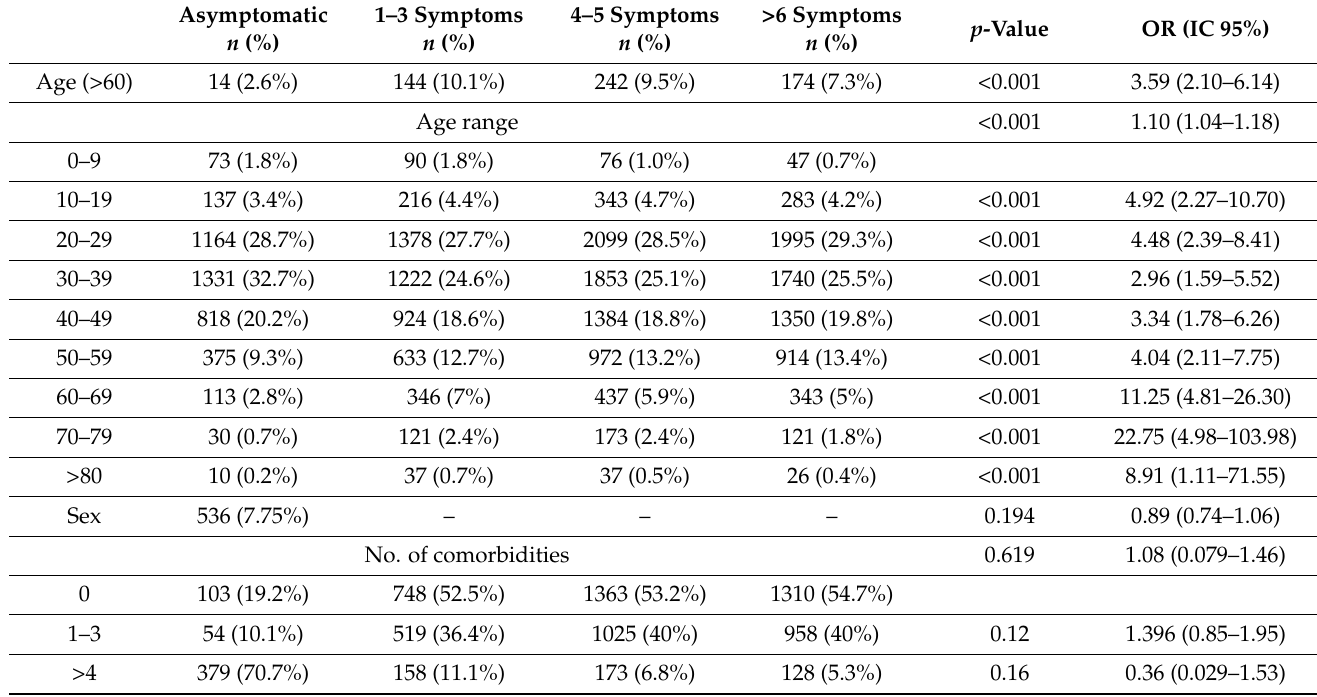
Table 3. Risk factors associated with the COVID-19 clinical presentation.